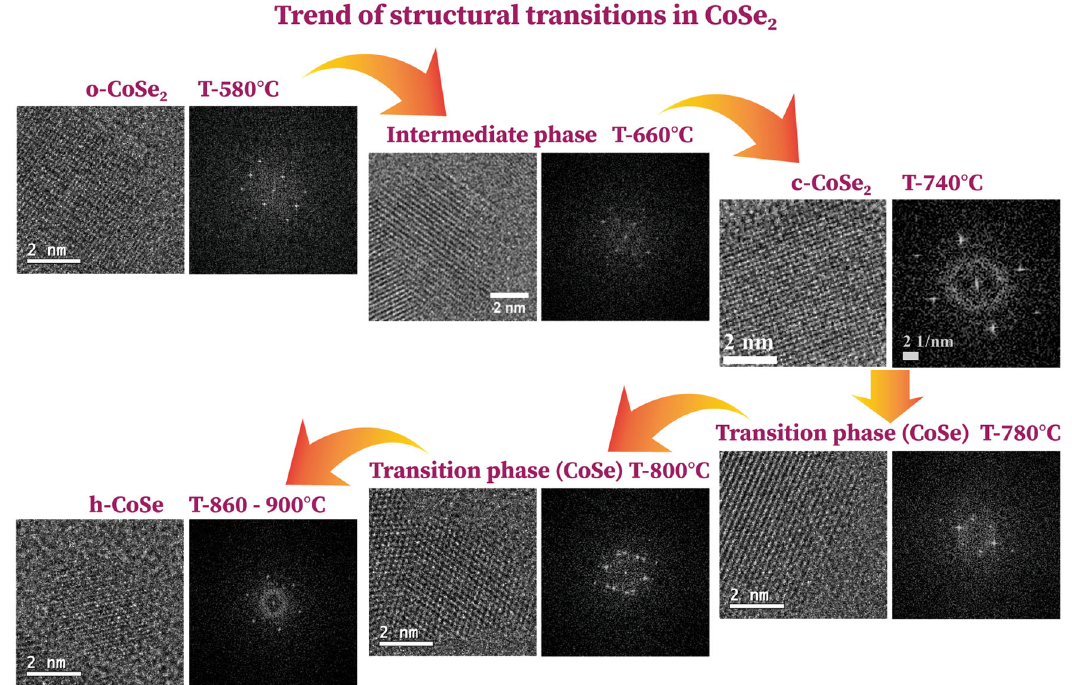
Fig. 5 Consecutive structural transitions in CoSe 2 . These transitions were observed in situ at the indicated temperatures, in one particular area of the sample, and follow the commonly observed trend. The scale bars represent 2 nm.